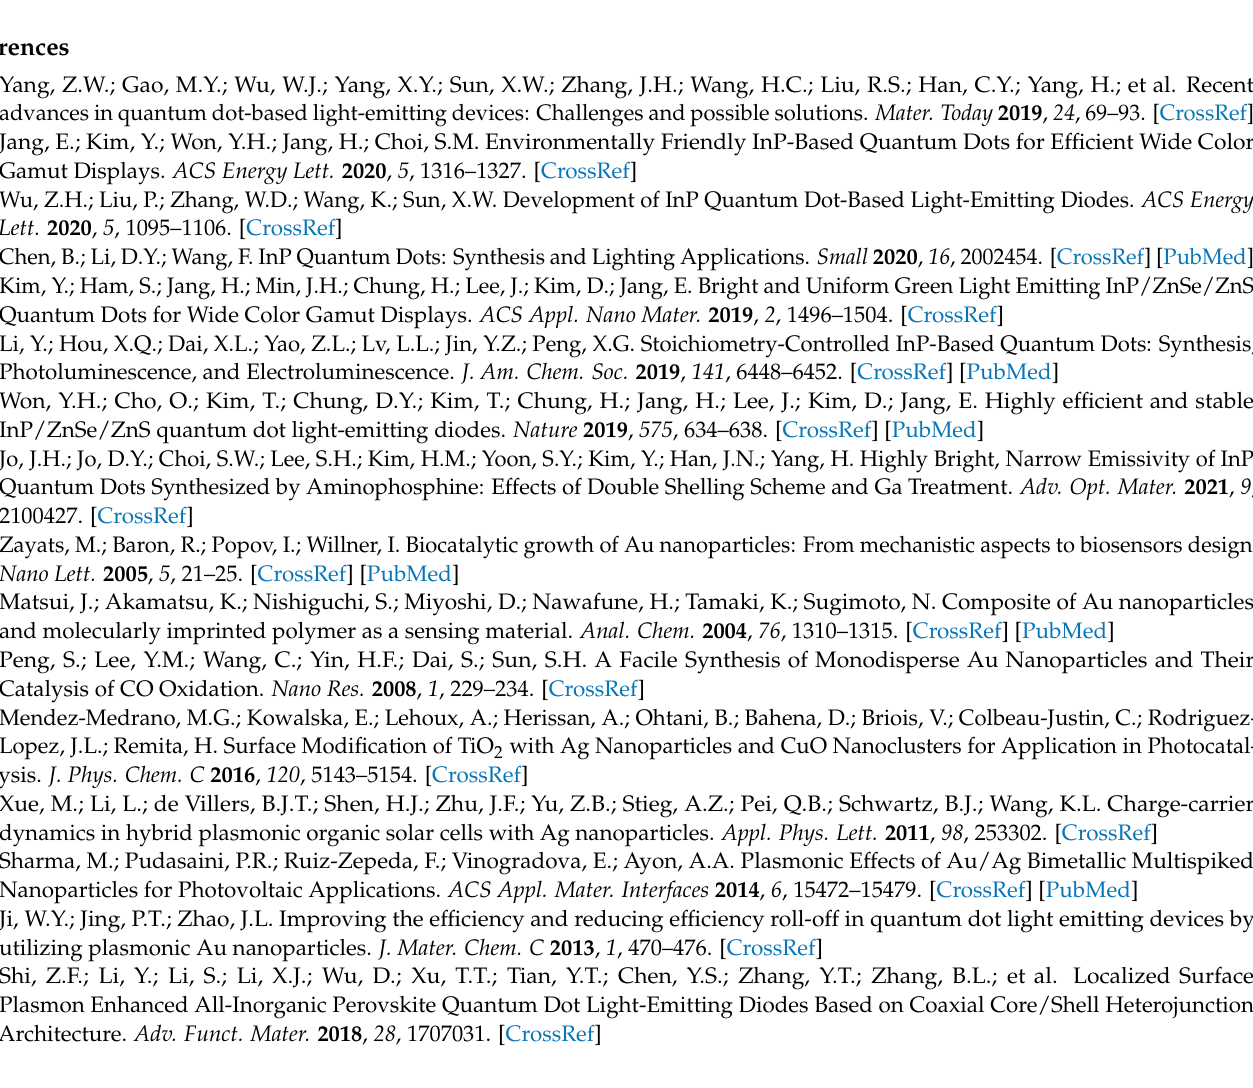
Figure S5: Typical transmittance spectra of commercial LCD green and red color